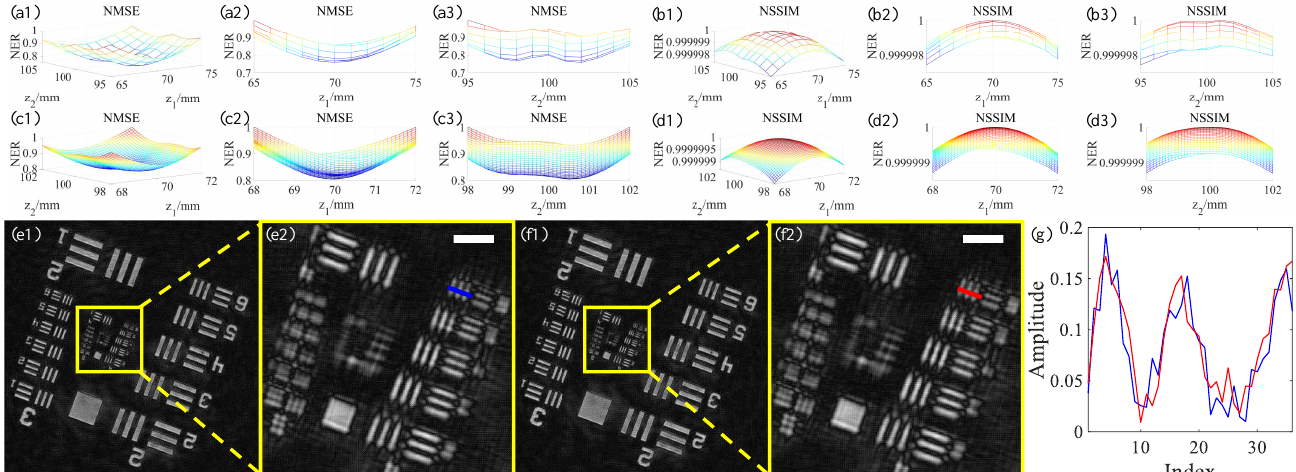
Figure 11. Auto-focusing curves and sample reconstruction results. ( a1 – a3 ) and ( b1 – b3 ) are the rough auto-focusing curves of NMSE and NSSIM, respectively; ( c1 – c3 ) and ( d1 – d3 ) are the fine auto-focusing curves of NMSE and NSSIM, respectively; ( e1 , e2 , f1 , f2 ) are the reconstruction results using the quasi-focal distances from ( c1 , d1 ), respectively; ( g ) pixel contrast curves. The white bar corresponds to 200 µ